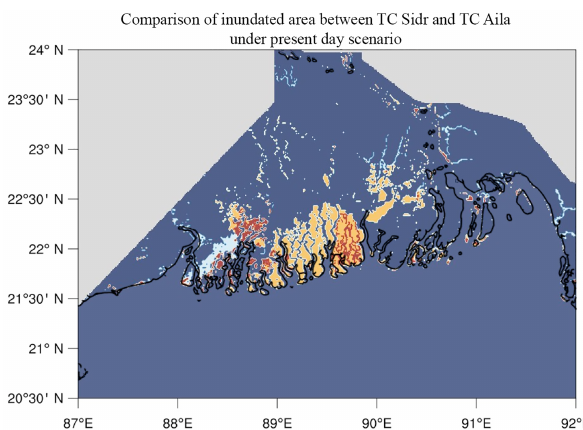
Figure 4. Yellow denotes the areas flooded by TC Sidr but not by Aila, and the white represents the area inundated by TC Aila but not by Sidr. Red is the area flooded by both TC Sidr and TC Aila. Blue shows the non-flooded area (either land or constant water).